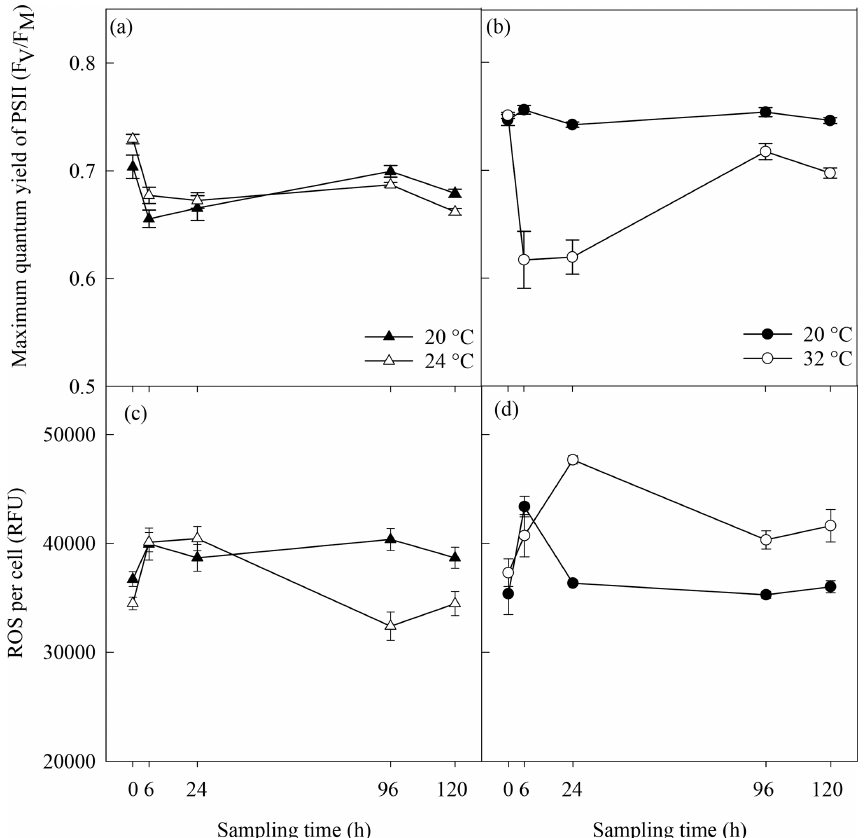
Figure 2. Photosynthetic efficiency (a, b) and reactive oxygen species (ROS) (c, d) in A. minutum cultures in experiment 1 (20 and 24 ◦ C) (a, c) and experiment 2 (20 and 32 ◦ C) (b, d) ; average ± SE, n =